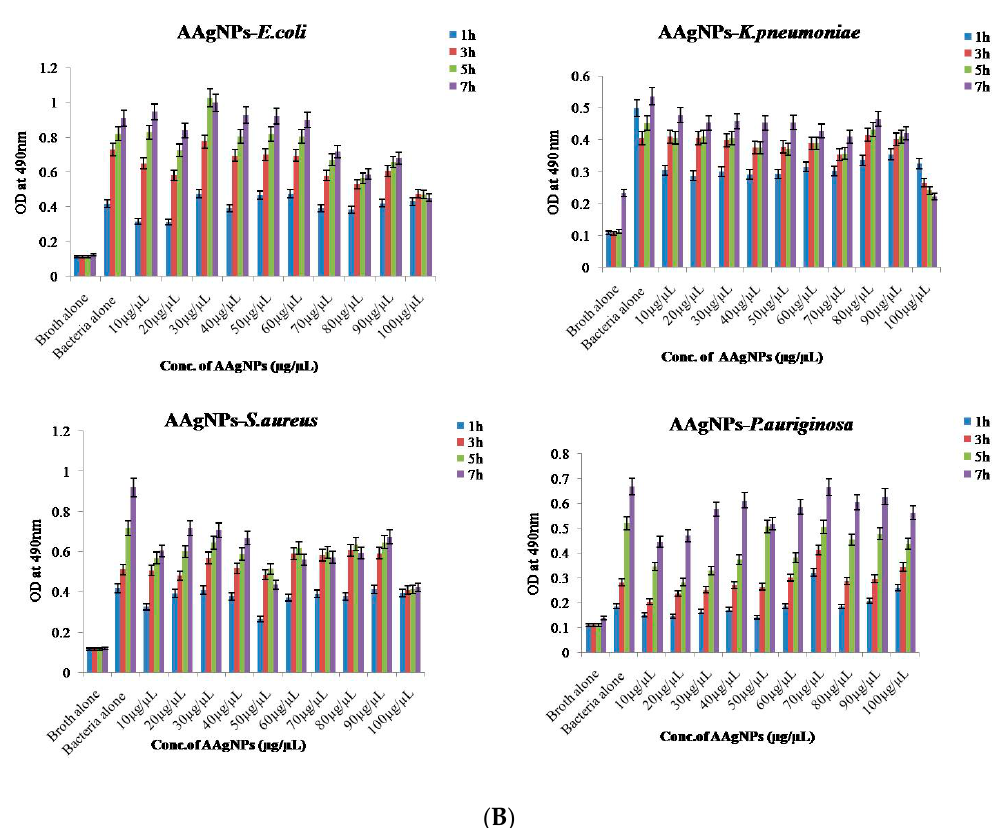
Figure 8. ( A ) Turbidity test for C. roseus Ag NPs (C Ag NPs) in MDR bacteria. ( B ) Turbidity test for A.indica Ag NPs (A Ag NPs) in MDR bacteria.